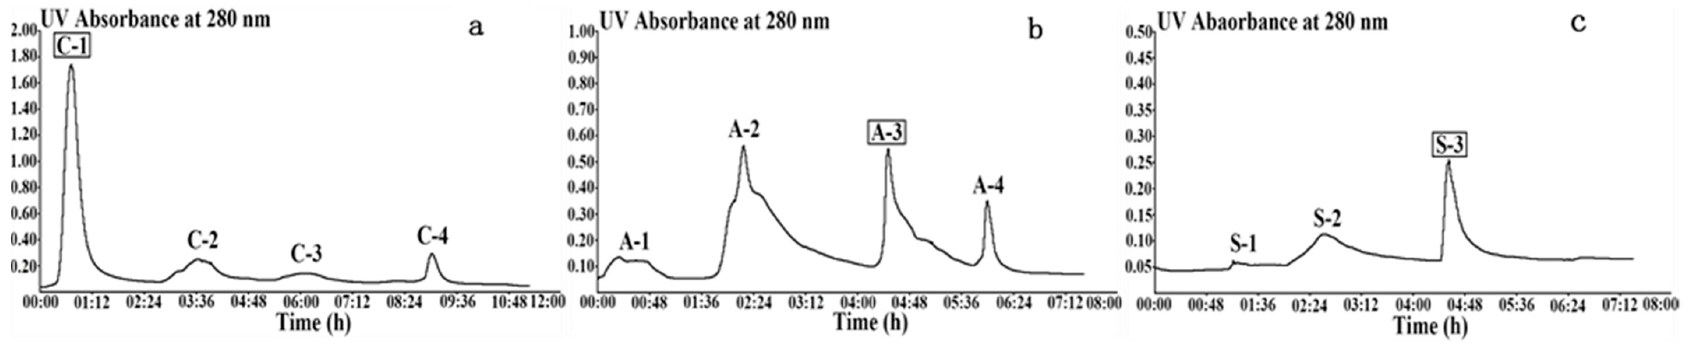
Figure 1. Chromatography of purification of endo-1,4- β -xylanase . a) SP-Sepharose Fast Flow cation exchange chromatography. b ) Q-Sepharose Fast Flow anion- exchange chromatography. c ) Source 30Q anion-exchange chromatography. The ordinate of a , b , c is absorbance (280 nm) and the abscissa is time (h).